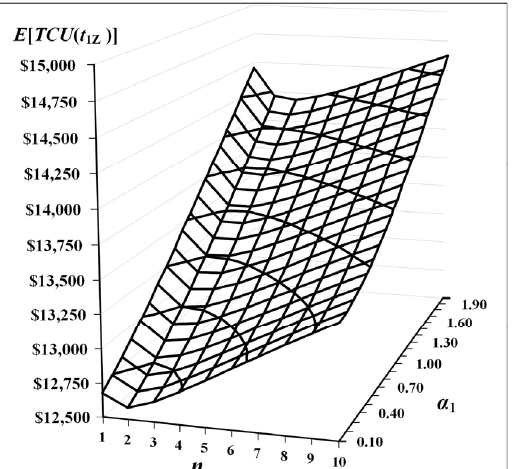
1 and n on t 1Z *